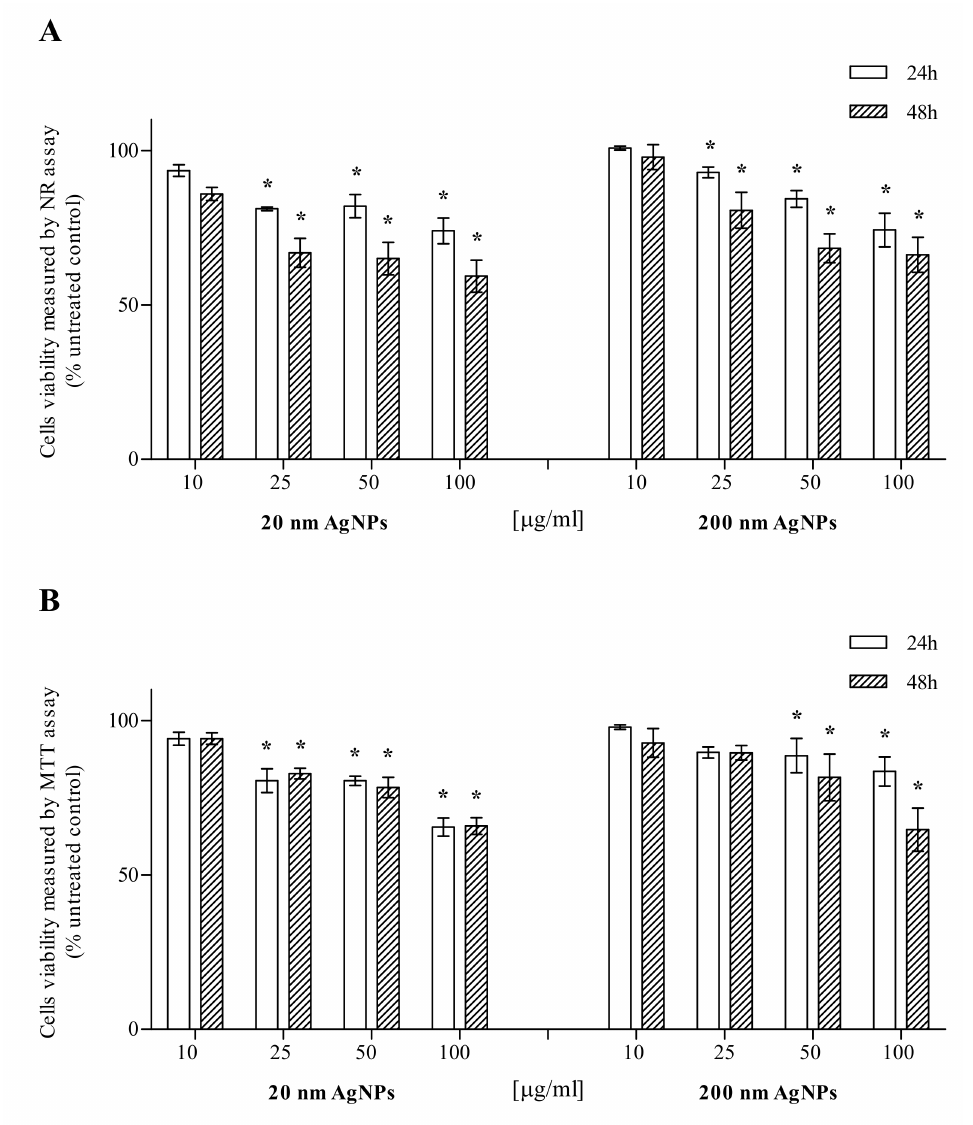
Figure 1. Cytotoxic e ff ect of 20 or 200 nm AgNPs on the MDA-MB-436 cell line. Viability was measured using NR ( A ) and MTT ( B ) assays and presented as a percentage of the untreated control. Data were expressed as mean ± standard deviation ( n = 3). Statistical significance: * p <